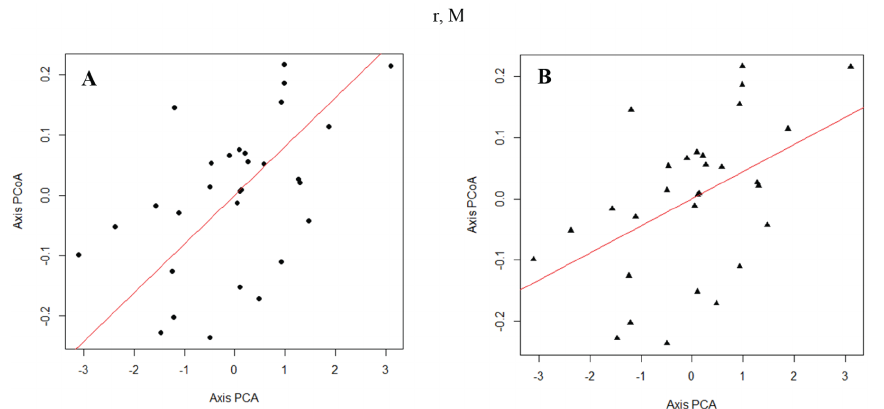
Figure 4. Relationship of the axes PCoA (A) average abundance of Trichoptera genera; (B) average abundance of Trichoptera) associated to E. crassipes with PCA axis (physiochemical variables) in the 15 marginal lakes along the Paraguay River, MT, sampled in September